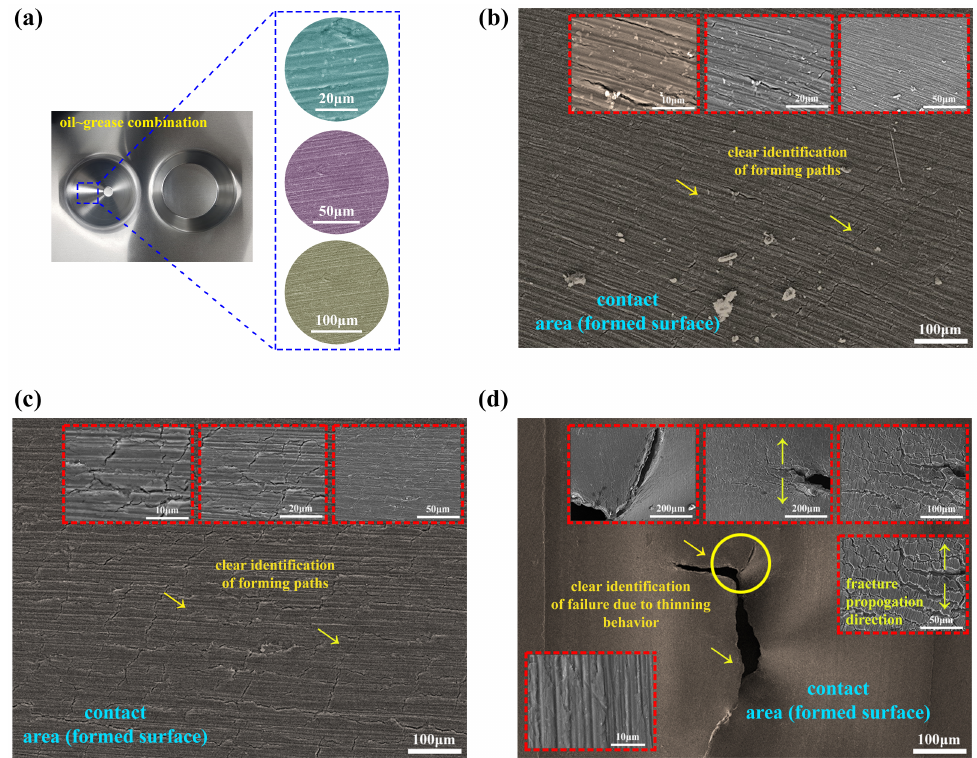
Figure 13. FESEM images at various magnifications: ( a ) surface from oil–grease lubricant used; ( b ) unfrac- tured scanned surface from 60° part; ( c ) unfractured scanned surface from 30° part; ( d ) fractured